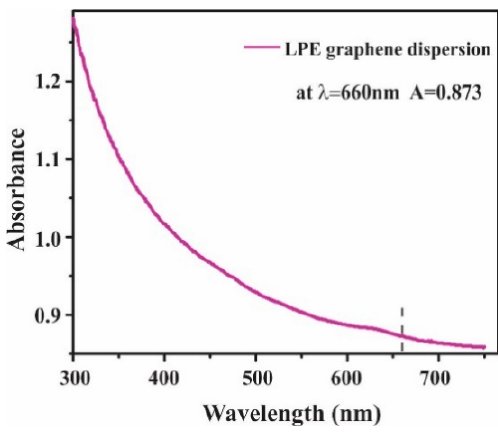
Figure 2. UV-VIS absorption spectrum of LPE graphene dispersion.